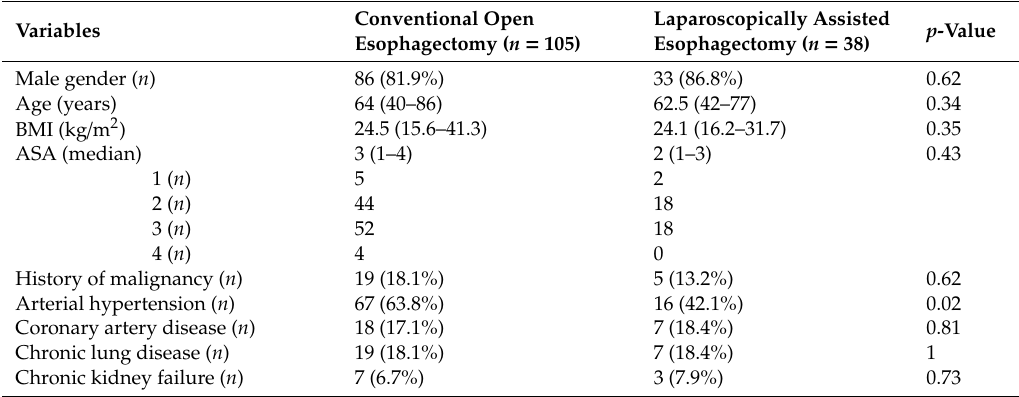
Table 1. Patient